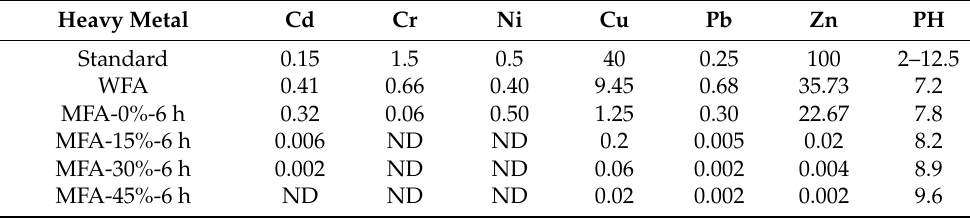
Table 3. Leaching concentrations of heavy metals in the different fly ash